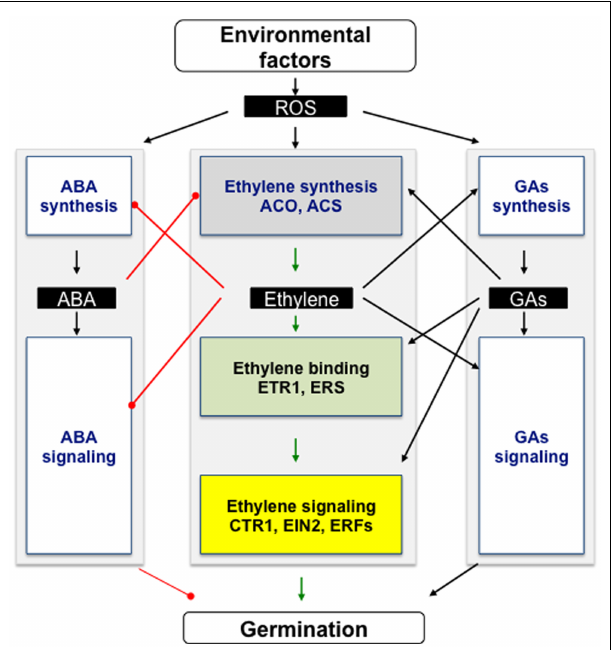
FIGURE 2 | Interactions between ethylene, abscisic acid, gibberellins, and ROS in the regulation of seed germination and dormancy. This scheme is based on genetic analyses, microarray data, and physiological studies on seed responsiveness to ethylene, ABA, GAs, or ROS cited in the text. Ethylene down-regulates ABA accumulation by both inhibiting its synthesis and promoting its inactivation or catabolism, and also negatively regulates ABA signaling. ABA inhibits ethylene biosynthesis through ACS and ACO activities. Ethylene also improves the GAs metabolism, and GAs signaling, and vice versa . ROS enhance ABA catabolism and both C 2 H 4 and GAs signaling.Whether ROS are signals induced by environmental factors to modulate the hormonal network toward germination is to be investigated. → and — • arrows indicate positive and negative interactions between the different elements of the signaling cascade,